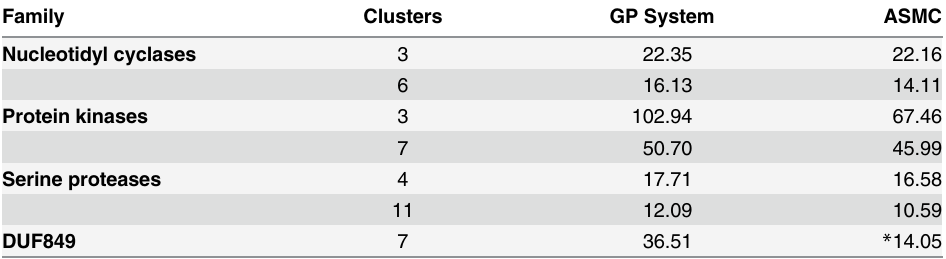
Table 4. Comparison of Mutual Information (MI) values for the clusterings obtained by each technique for the studied protein